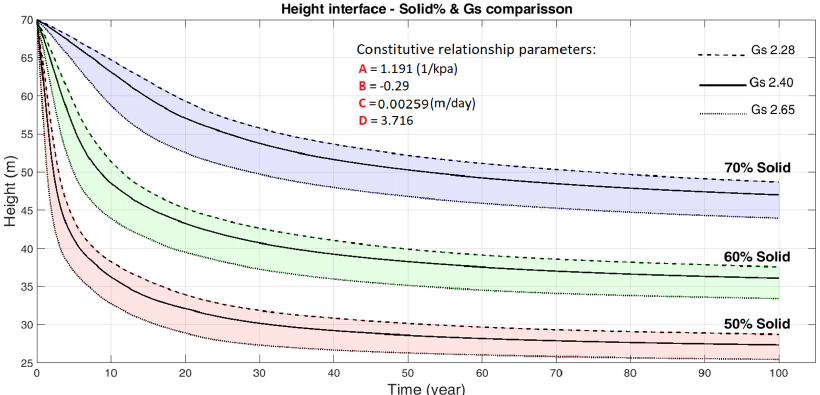
Figure 7. Settlement curves: solids contents and specific gravity scenarios—a thickened tailings case.